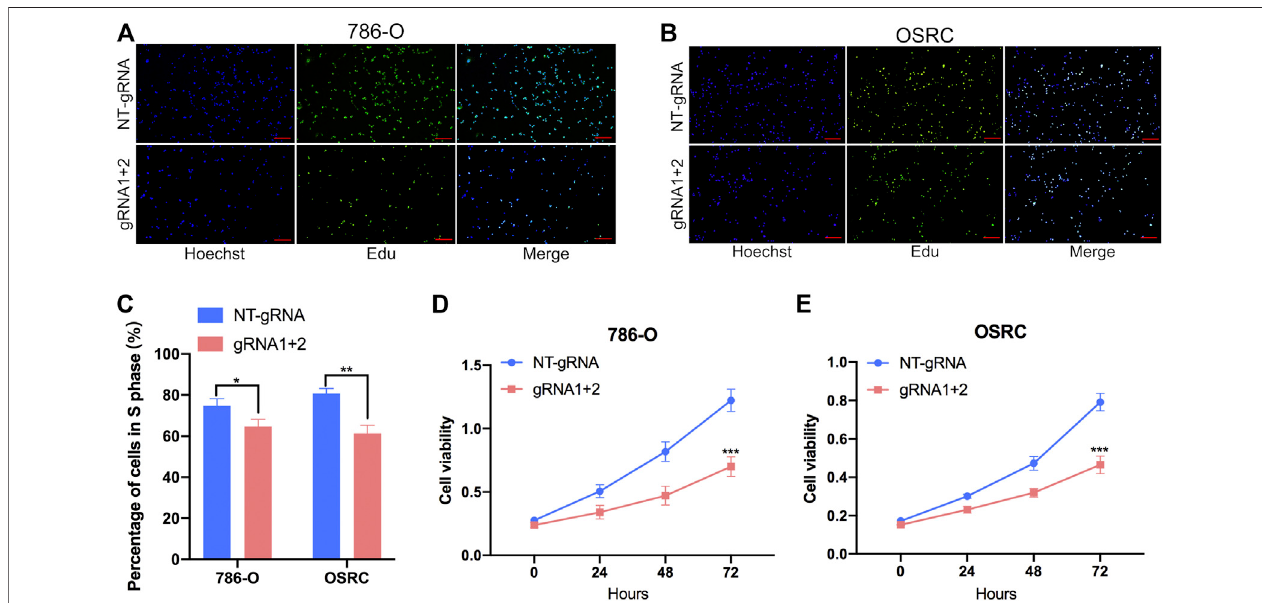
FIGURE 4 | Targeting demethylation of PLOD2 transcripts by dCas13b-ALKBH5 inhibited RCC cells proliferation. (A – C) EdU assays of 786-O and OSRC cells after transfected withdCas13b-ALKBH5andsgRNAs. (D,E) CCK-8assaysof786-OandOSRCcellsaftertransfected withdCas13b-ALKBH5andsgRNAs. * p < 0.05, ** p < 0.01, *** p < 0.005.